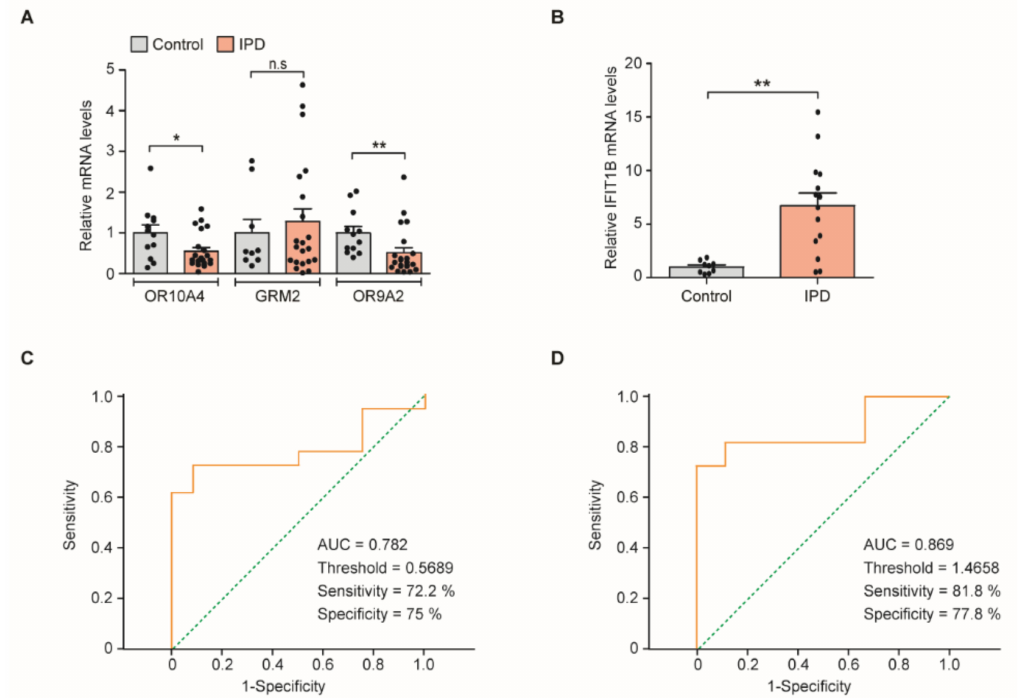
Figure 3. Quantitative analysis of OR10A4 , OR9A2 , GRM2 , and IFIT1B transcripts in the cells obtained from human nasal fluid cells. ( A , B ) OR10A4 , OR9A2 , GRM2 , and IFIT1B in the cells obtained from the nasal fluid of PD patients and healthy controls determined by reverse-transcription quantitative PCR followed by normalization to the internal loading control GAPDH ( n = 12 control (con) and 22 PD for OR10A4 and GRM2 analysis, 10 con and 22 PD for OR9A2 analysis, and 9 con and 14 PD for IFIT1B analysis). ( C , D ) Receiver operating characteristic curve analysis of sensitivity and specificity for OR9A2 and IFIT1B as biomarkers of PD. The data are expressed as the mean ± SEM. * p < 0.05 and ** p < 0.01; nonparametric Mann–Whitney U test. AUC: area under the curve. n.s,